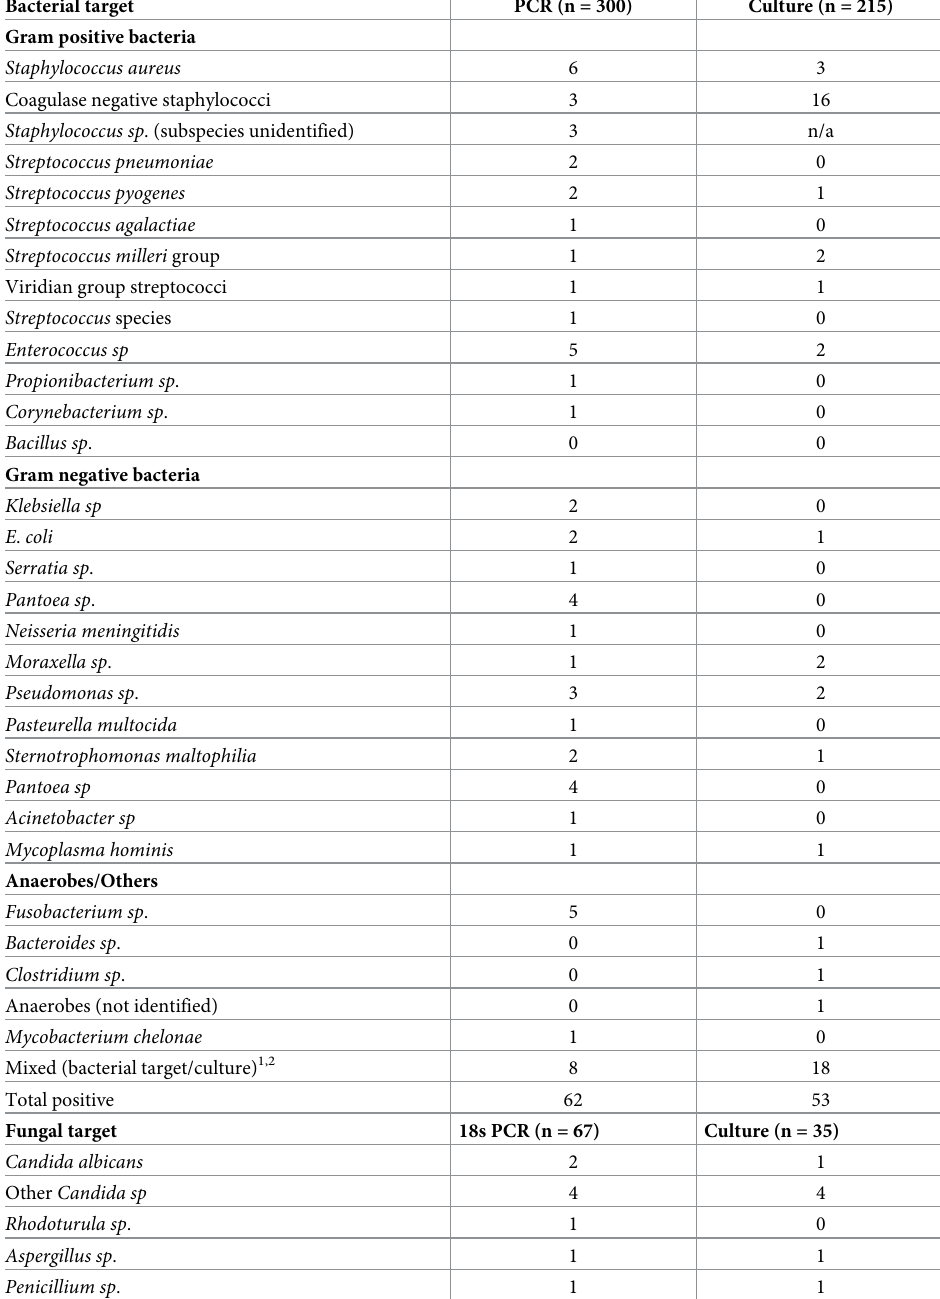
Table 2. Comparison of microbiological diagnosis by culture versus 16s/18s rRNA